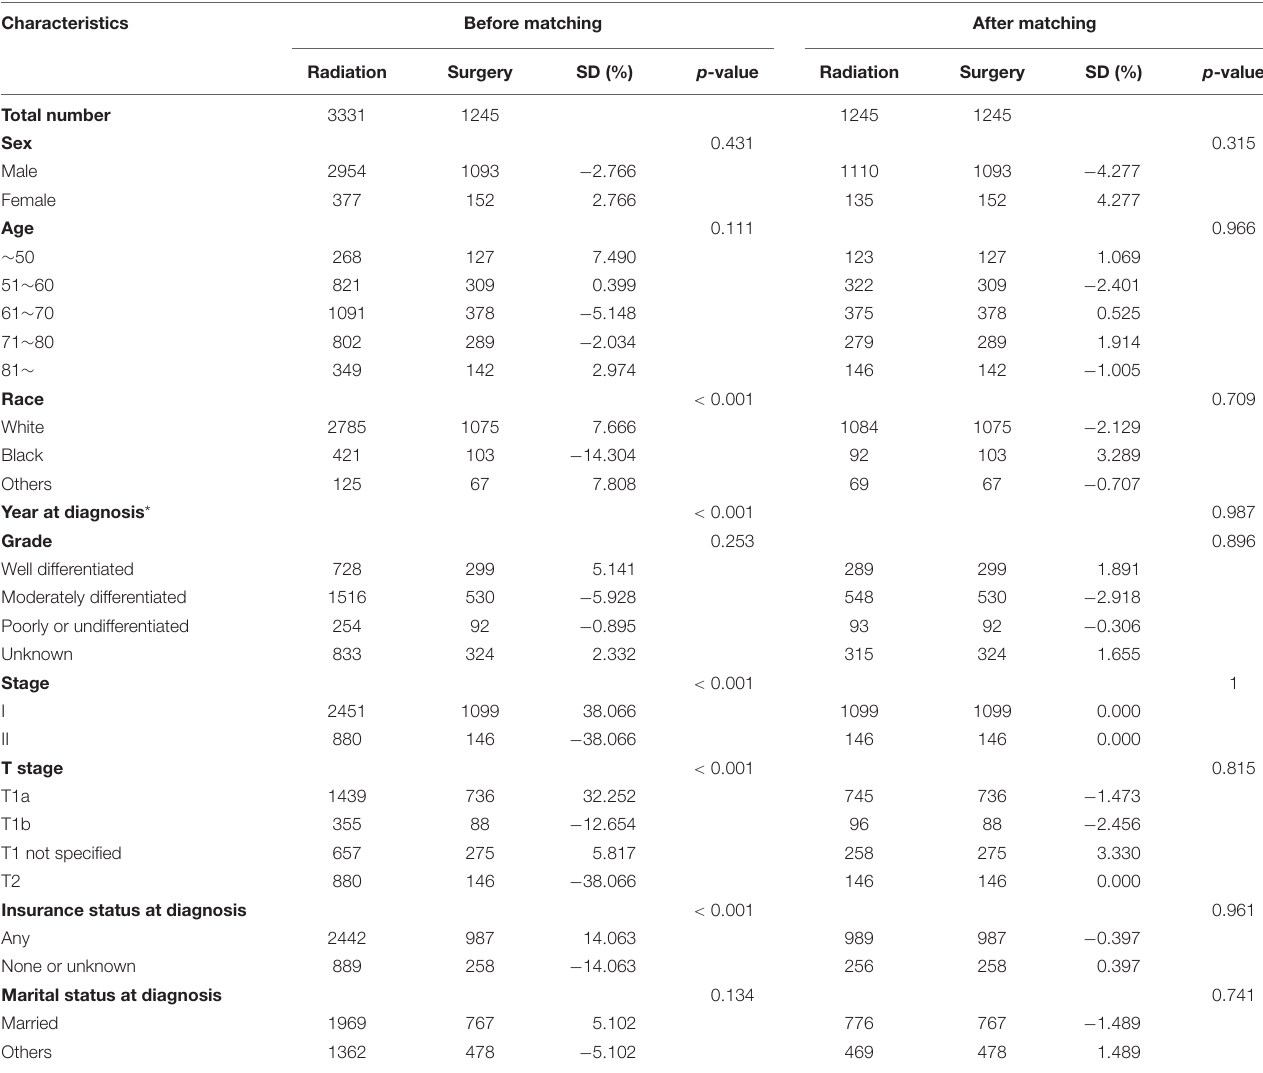
TABLE 1 | Patient characteristics according to the therapy status before and after propensity score matching.